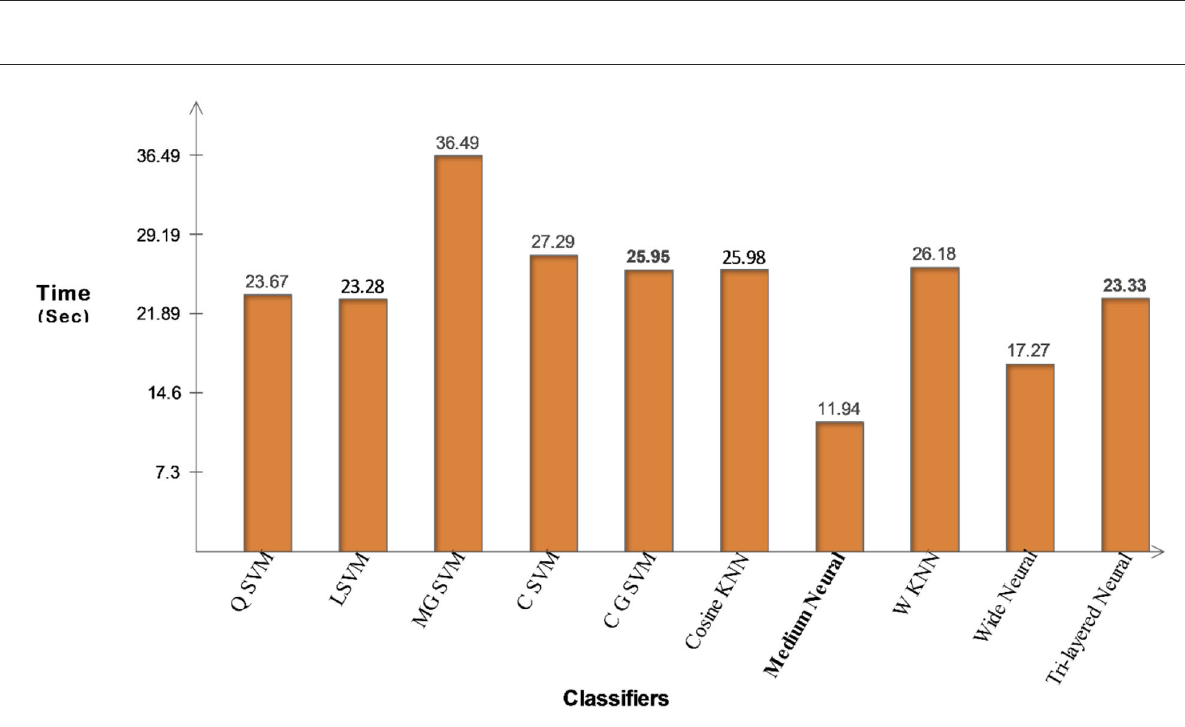
FIGURE13 Illustration of computational time for COVID-GAN and COVID-Net mini chest X-ray dataset after proposed optimization